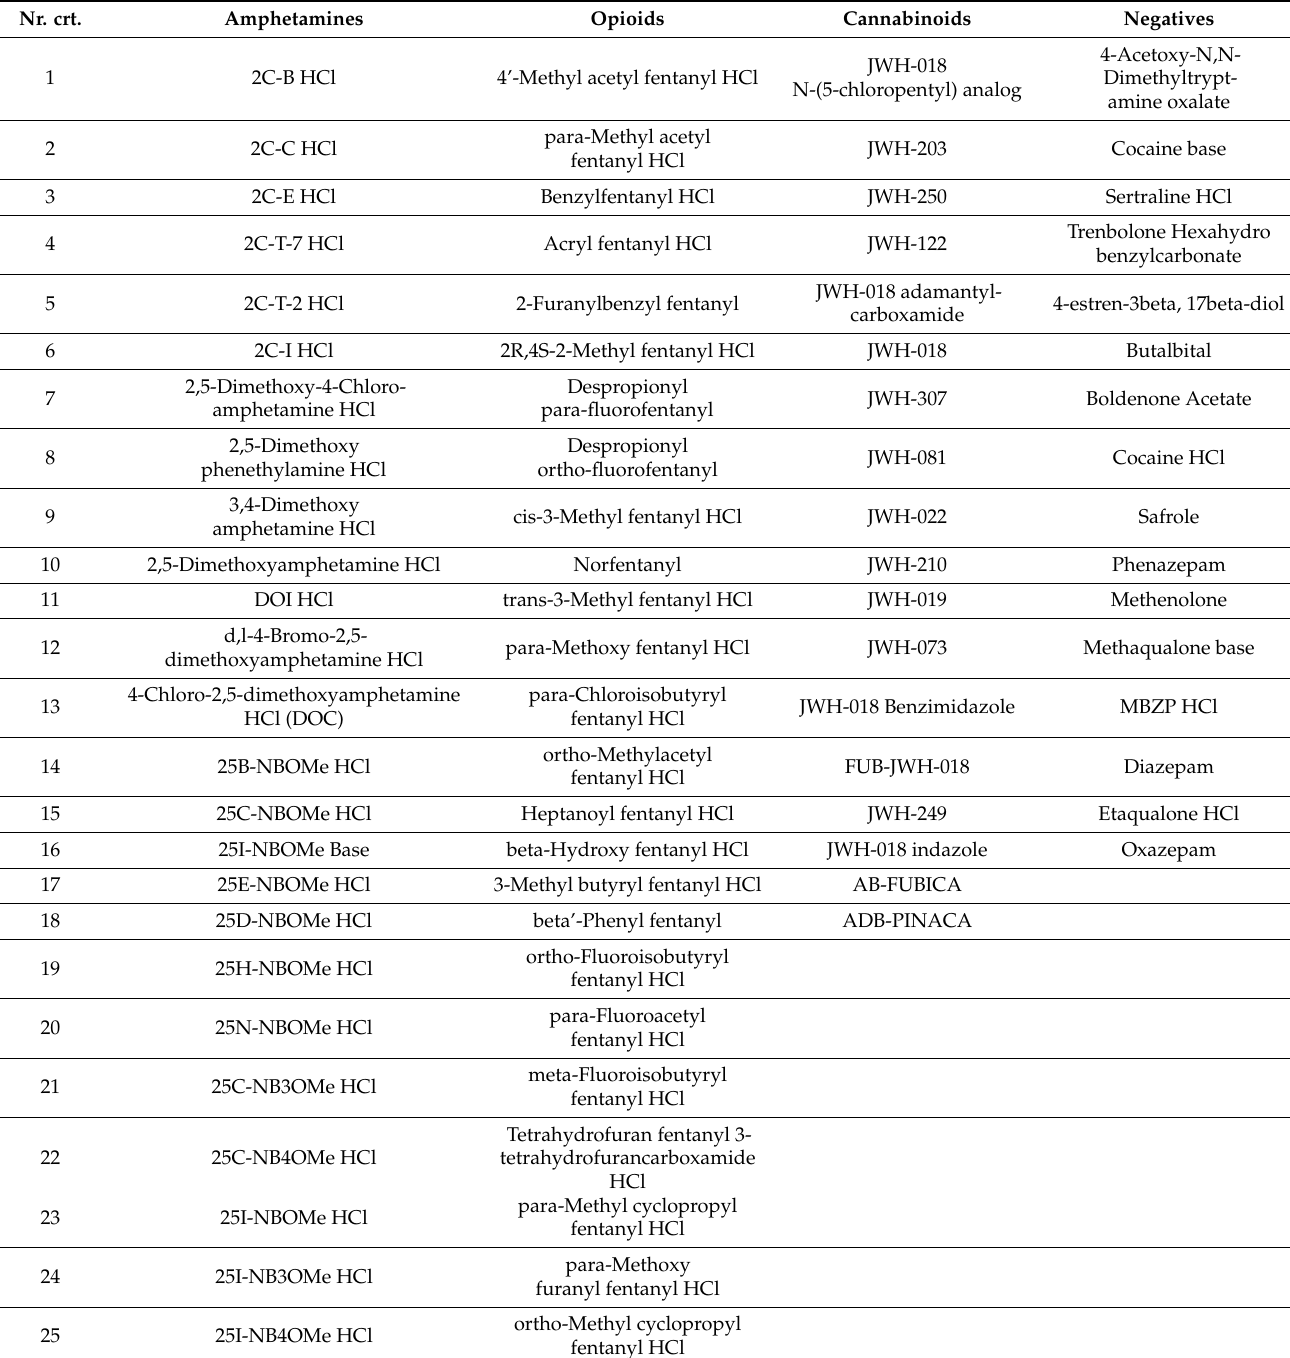
Table 1. Compounds included in the